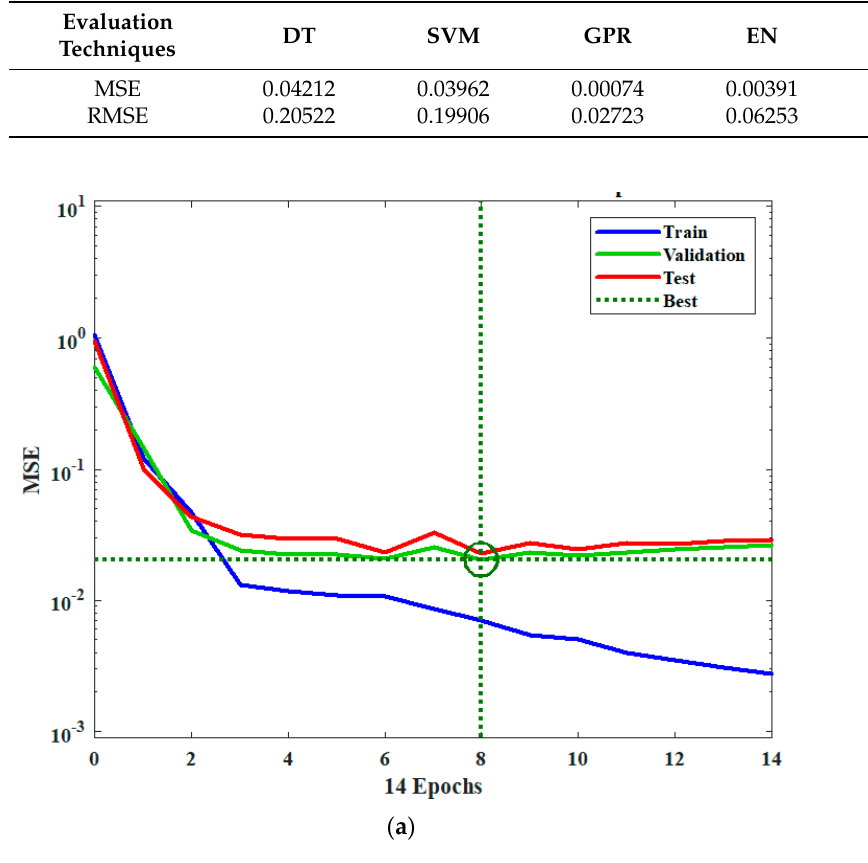
Table 3. Comparison of the ORLT models with the ANN model.